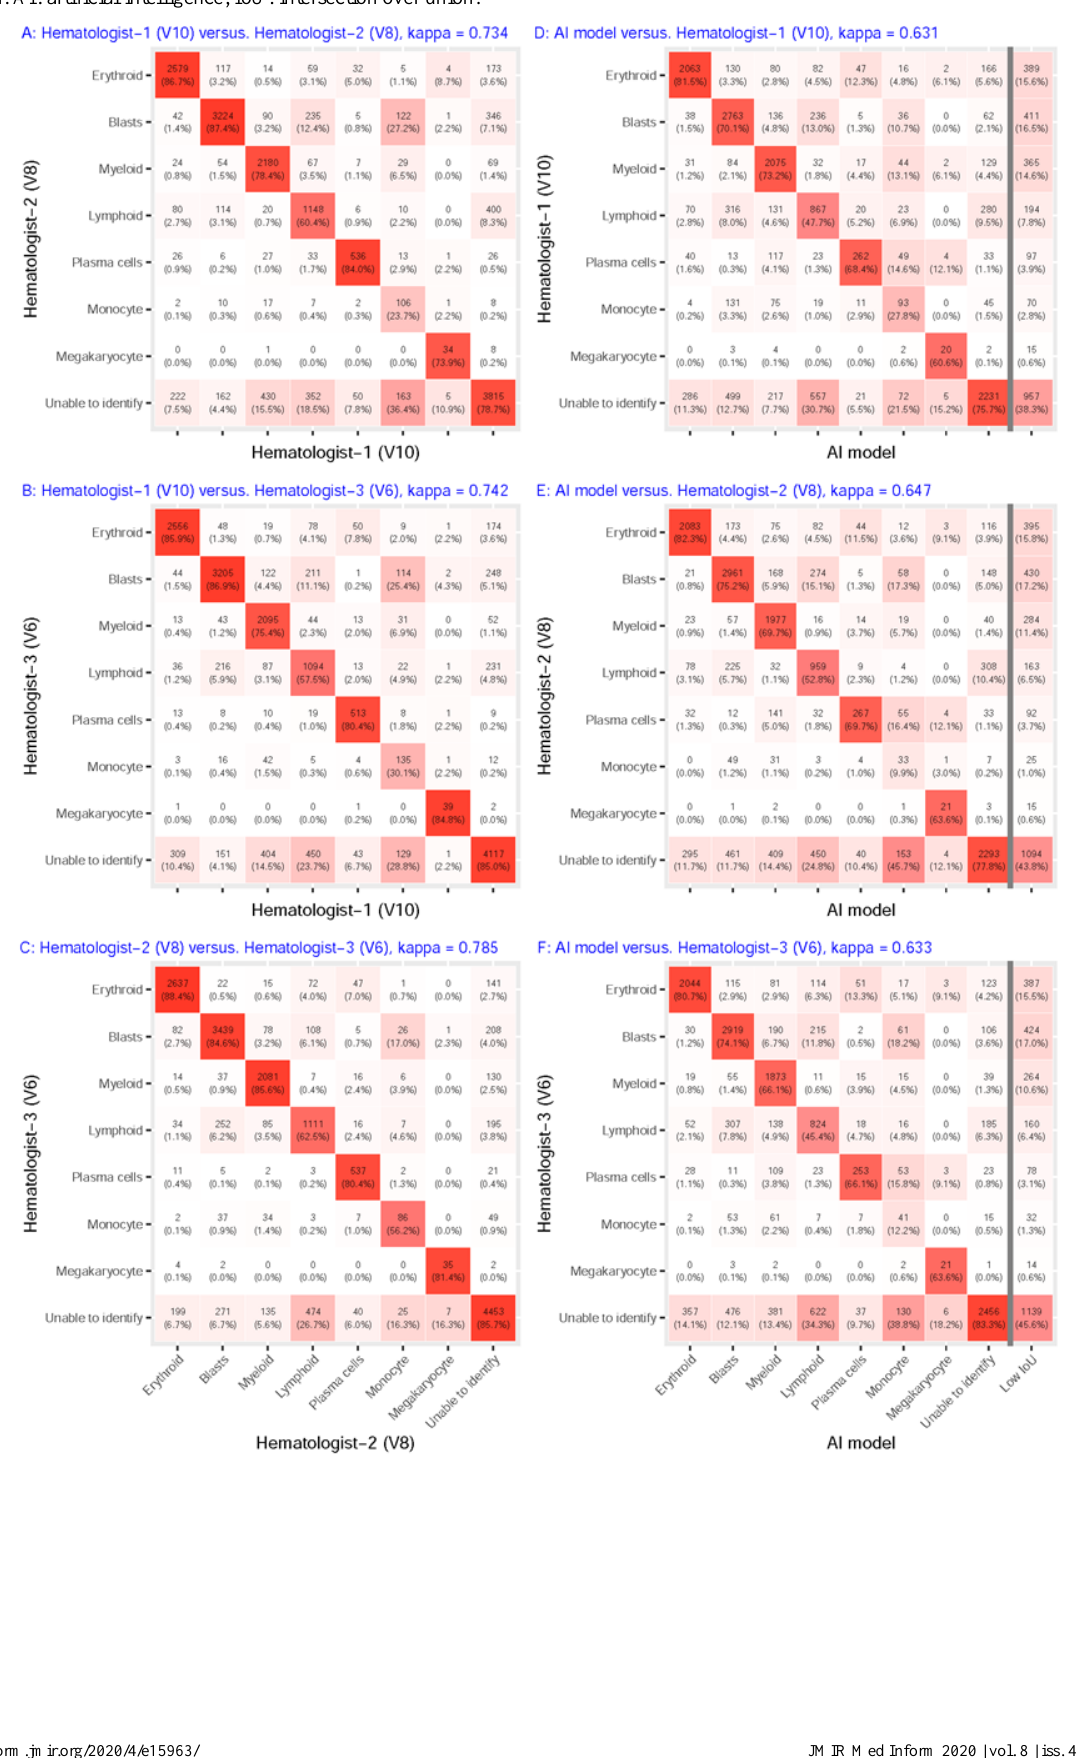
Figure 3. Cell-based consistency analysis in the development cohort. Each confusion matrix compares one of the three hematologists and AI. The kappa value is based on the eight-category classification, and 14.40% (2498/17,347) of cells that had lower IoUs were ignored in the AI-hematologist comparison. AI: artificial intelligence; IoU: intersection over